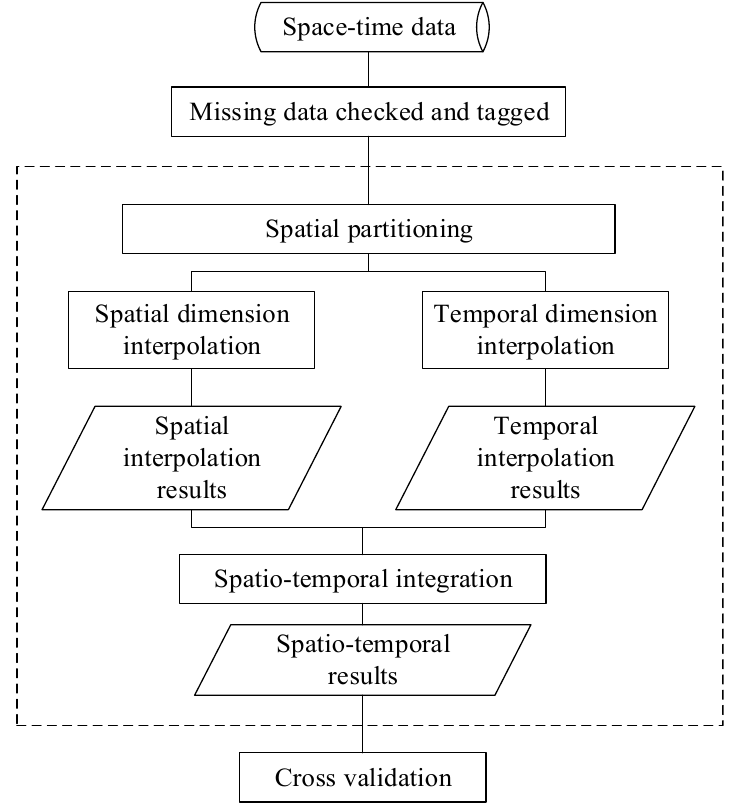
Figure 1. The flowchart of this method.